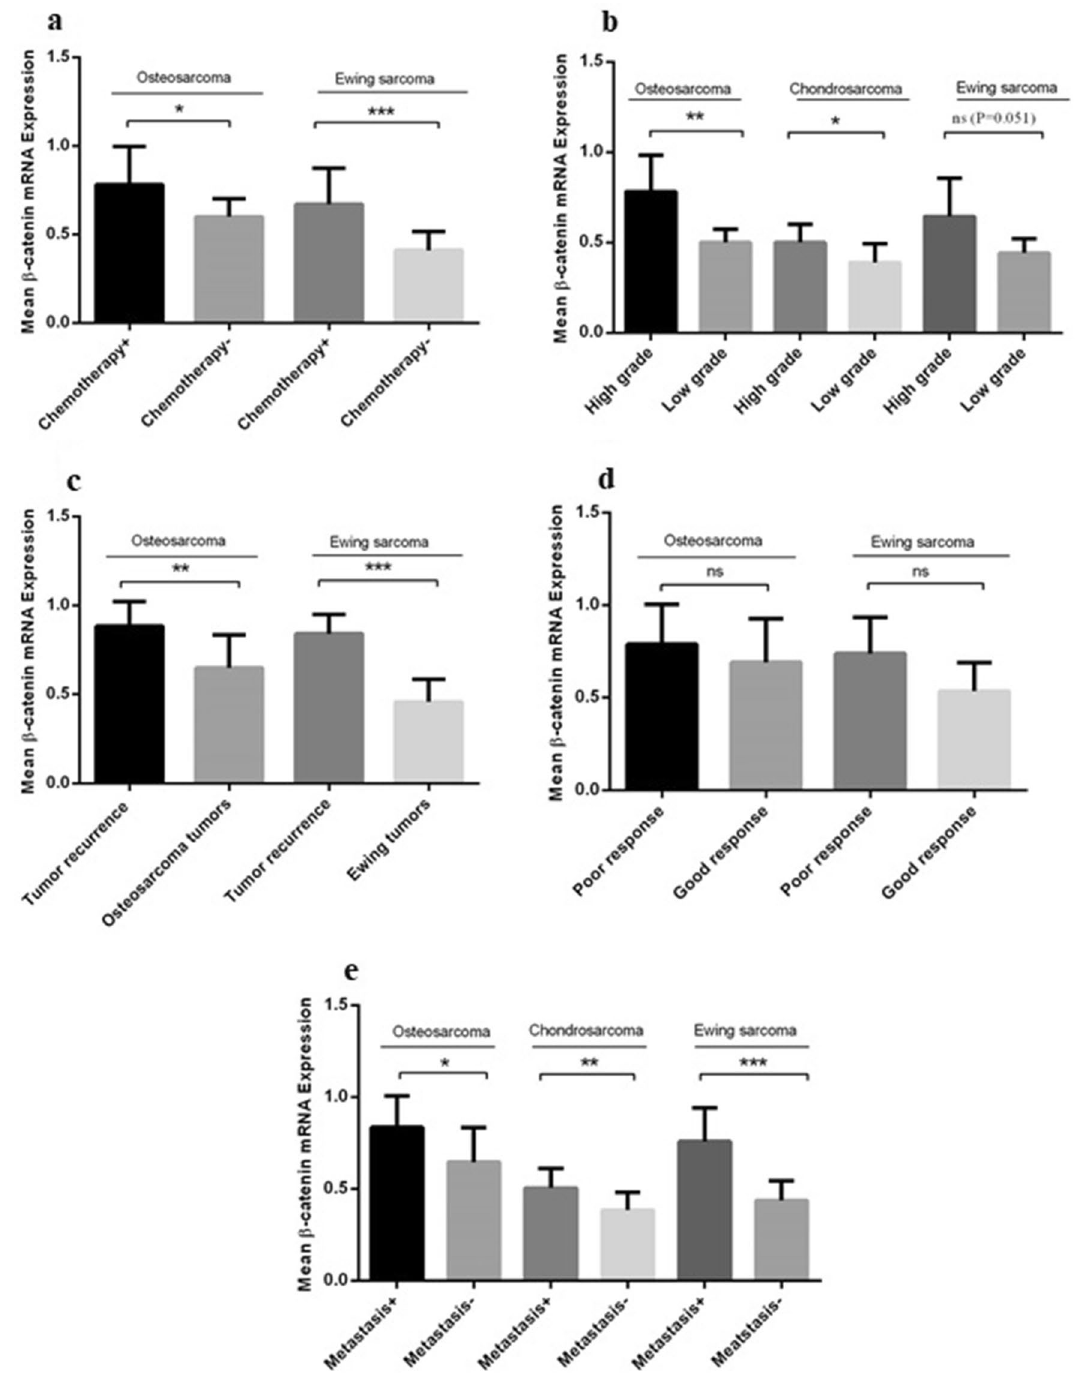
Figure 4. The circulating level of β-catenin expression in patients with different malignant bone tumors. The mRNA expression level of β-catenin in PBMCs of patients with different types of malignant bone tumors was assessed. The increase in the mRNA expression level of β-catenin was detected in PBMCs of chemotherapy- received patients with osteosarcoma and Ewing’s Sarcoma tumors ( a ), PBMC of patients with high-grade osteosarcoma and chondrosarcoma tumors ( b ), PBMC of patients with recurrent osteosarcoma and Ewing’s Sarcoma tumors ( c ). The β-catenin mRNA expression in PBMC of patients with poor response to chemotherapy of osteosarcoma and Ewing’s Sarcoma tumors was not significant ( d ). The β-catenin expression level in PBMC of patients with metastatic osteosarcoma, Ewing’s Sarcoma and chondrosarcoma tumors was increased compared to the non-metastatic groups ( e ). The t-student test was used to compare the difference in β-catenin expression in PBMC of patients with different malignant bone tumors and their subgroups. The comparative CT (2 −ΔCt ) method was applied for gene expression analysis. The statistical differences between groups are shown as asterisk (*P < 0.05, **P < 0.01, ***P <